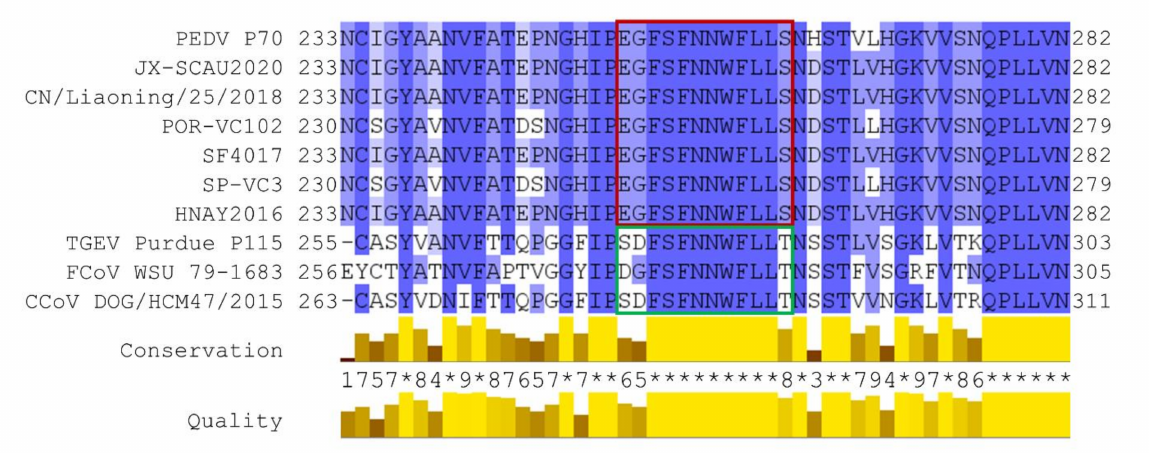
Figure 8. Multiple alignments of the amino acid sequences of spike proteins of various strains of PEDV that were published in PubMed during the past 5 years and other alphacoronaviruses. The amino acid sequences of PEDV that caused PED outbreaks included JX-SCAU2020 (GenBank: QUE39276.1); CN/Liaoning/25/2018 (GenBank: QCW07226.1); POR-VC102 (GenBank: QQO86882.1); SF4017 (GenBank: QEQ55819.1); SP-VC3 (GenBank: QQO86847.1); and HNAY2016 (GenBank: QQS74747.1). The sequences of other alphacoronaviruses include TGEV Purdue P115 (GenBank: ABG89325.1); FCoV WSU 79-1683 (GenBank: JN634064.1); and CCoV DOG/HCM47/2015 (GenBank: LC190907.1). The multiple sequence alignment revealed that the A3-epitope that was identified from the phage mimotope and overlapped S1 peptide-binding ELISAs, “EGFSFNNWFLLS”, is identical among the PEDV spike sequences (red box) and this sequence is found to be highly conserved among the other alphacoronaviruses (green